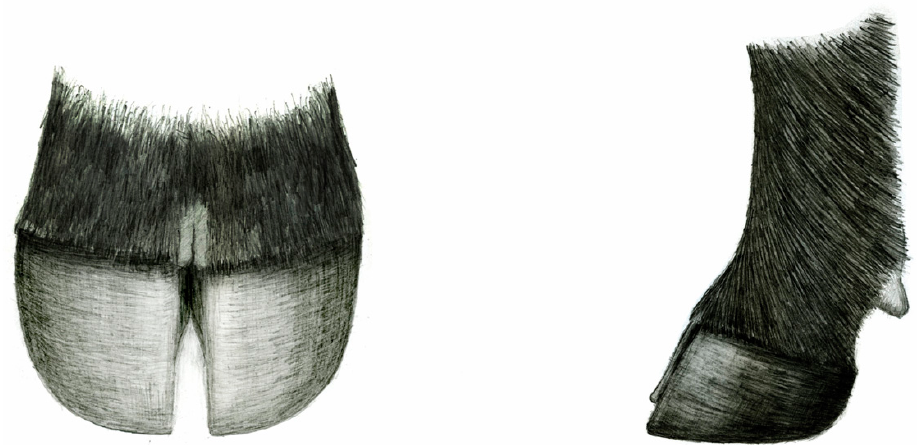
Figure 2. Examples of ideal claw and foot angle. Note the symmetry in the claw set and the 45-degree angle of the pastern joint (images courtesy of the American Angus Association).